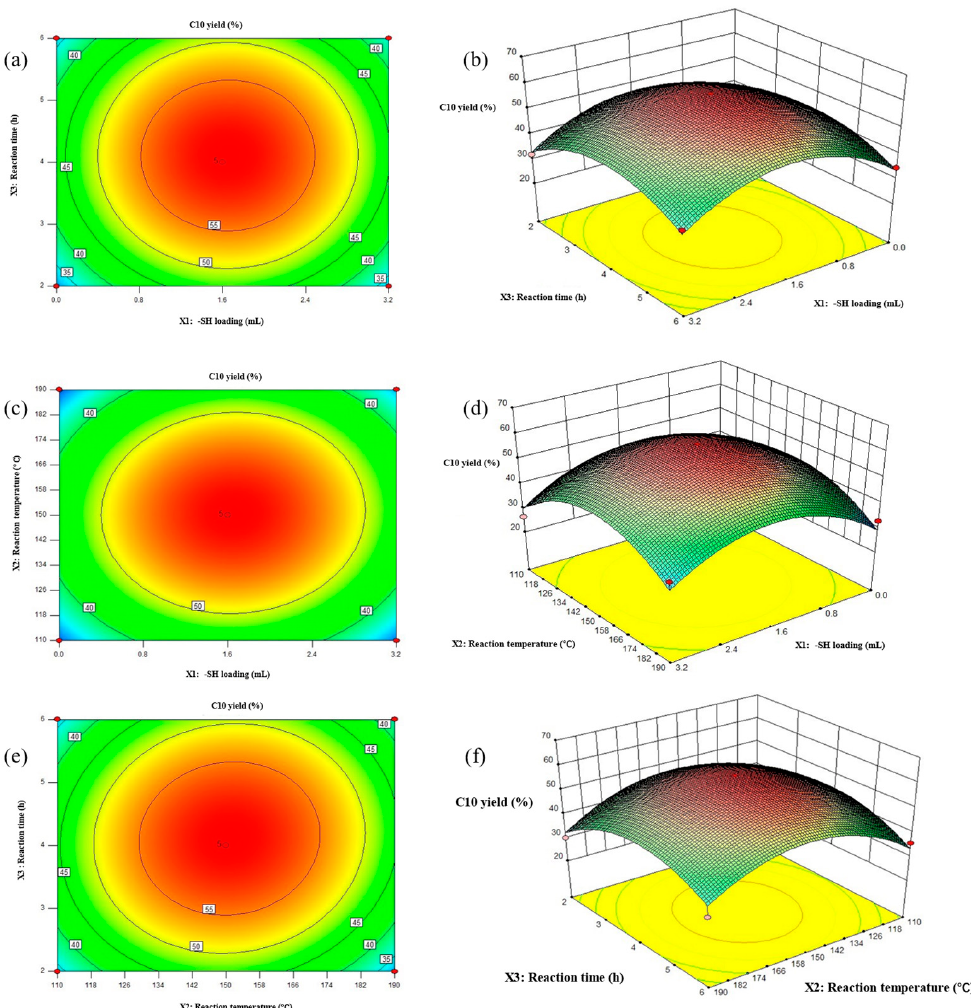
Figure 4. Response surface analysis of C10 yield in a cyclopentanone condensation reaction. Contour plot of C10 yield: ( a ) -SH loading and reaction time; ( c ) -SH loading and reaction temperature; ( e ) Reaction temperature and reaction time; Response surface diagram: ( b ) -SH loading and reaction time; ( d ) -SH loading and reaction temperature; ( f ) Reaction temperature and reaction time.